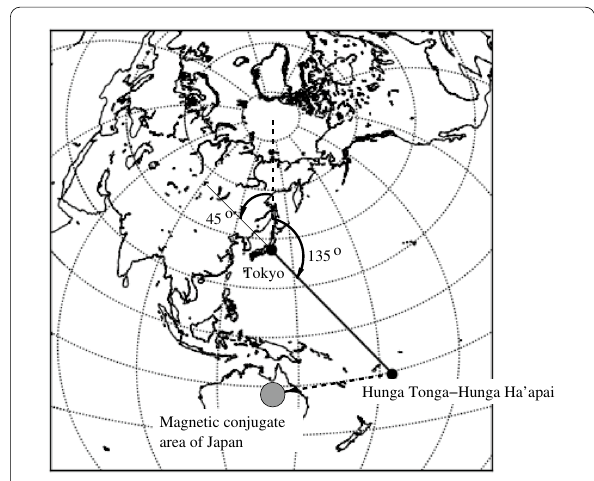
Fig. 5 Relative locations between Tokyo, Japan and Hunga Tonga-Hunga Ha’apai. The distance and direction are correct only from the center of the